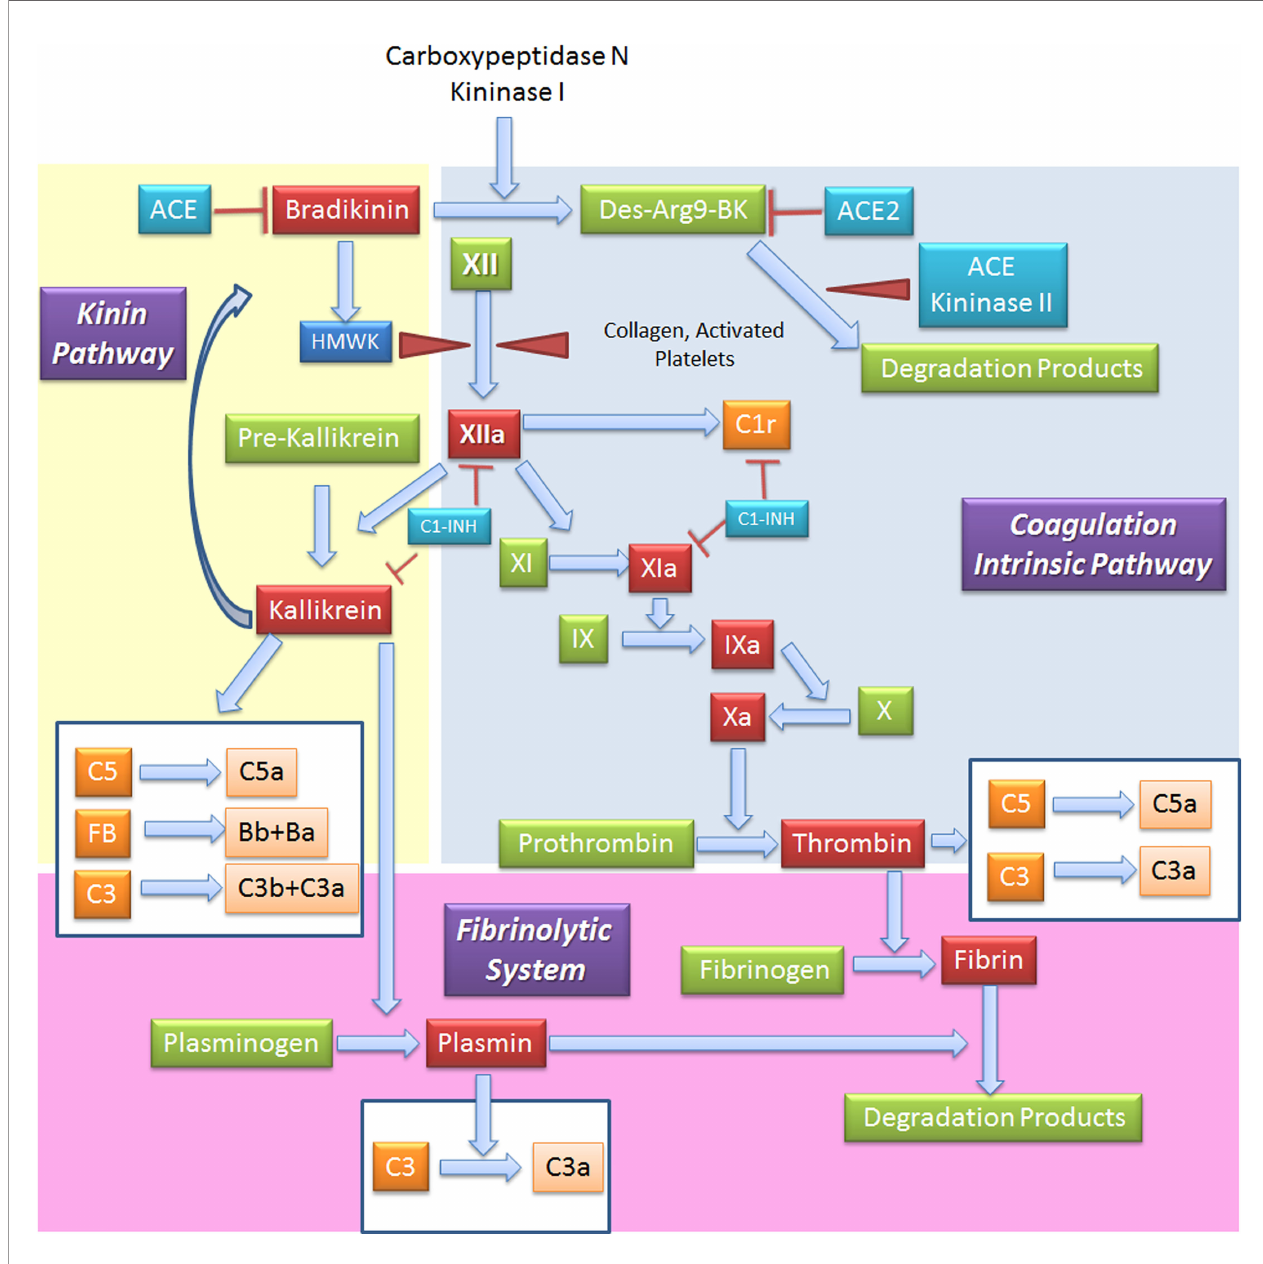
FIGURE 5 | Interplay between coagulation, fi brinolytic, contact and complement systems. The kinin system is comprised of proteins that participate in the coagulation and in fl ammation. In the kinin/contact system activation may occur via auto-activation of FXII in contact with negatively charged surfaces, or the plasma kallikrein-kinin system, as activation in plasma may be driven by pre-kallikrein activation. Kinins are vasoactive peptides produced by the action of a speci fi c protease, called plasma kallikrein on kininogens. Plasma kallikrein, through the cleavage of the plasma glycoprotein precursor high-molecular-weight kininogen (HMWK), produces bradykinin. Bradykinin (BK) causes increase in vascular permeability, contraction of smooth muscle, dilation of blood vessels, and pain when injected into the skin, with similar effects to histamine. It exerts pro fi brinolytic properties by stimulating release of tissue plasminogen activator from endothelial cells. BK is quickly inactivated by redundant membrane and soluble kininase. The coagulation intrinsic pathway of the coagulation system is composed by plasma proteins activated by FXII, a protein synthesized by the liver that can be activated by collagens, basal membrane and activated platelets. The coagulation system culminates in the formation of thrombin (FIIa) from prothrombin (FII) and in the formation of fi brin from the soluble fi brinogen. When generated, FXIIa is also responsible of the activation of other three systems: (a) C, via activation of C1r and C1s; (b) in fl ammatory kallikrein-kinin pathway by converting pre-kallikrein into active plasma kallikrein, inducing the cleavage of both FXII into FXIIa and high molecular weight kininogen to BK; and (c) fi brinolytic system by plasma kallikrein activation, in turn cleaving plasminogen into plasmin, an enzyme that degrades fi brin clots. Several coagulation system enzymes, including thrombin, FIXa, FXa, FXIa, and kallikrein, directly activate C5. Kallikrein also activates C3 and factor. ACE, Angiotensin-converting enzyme; C1-INH, C1-inhibitor; FB, Factor